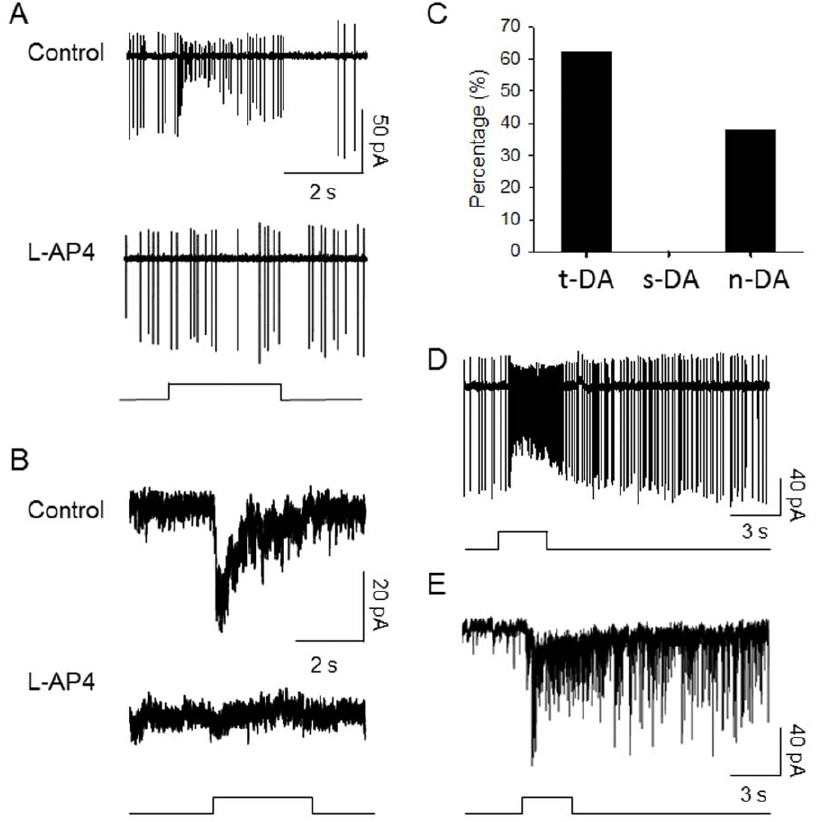
Figure 1. Transient-type light responses recorded from dopaminergic neurons in melanopsin knockout mouse retinas. (A) Loose patch recordings of action potentials, (B) whole cell recordings of light-induced inward currents. Bottom traces are recordings in the presence of 30 m M L-AP4 (C) Percentage of dopamine neurons exhibiting transient light responses (t-DA), sustained light responses (s-DA), and null light responses (n-DA). (D) Light-evoked spikes from a sustained-type dopamine neuron in a wild-type retina (n=8). (E) Light-induced inward currents from a sustained-type dopamine neuron in a wild-type retina (n=2). Stimulus bars indicate timing of 3 s pulses of 525 nm light in A, B (1.9 6 10 14 photons cm 2 2 s 2 1 ) and 470 nm light in D and E (1.47 6 10 13 photons cm 2 2 s 2 1 ).